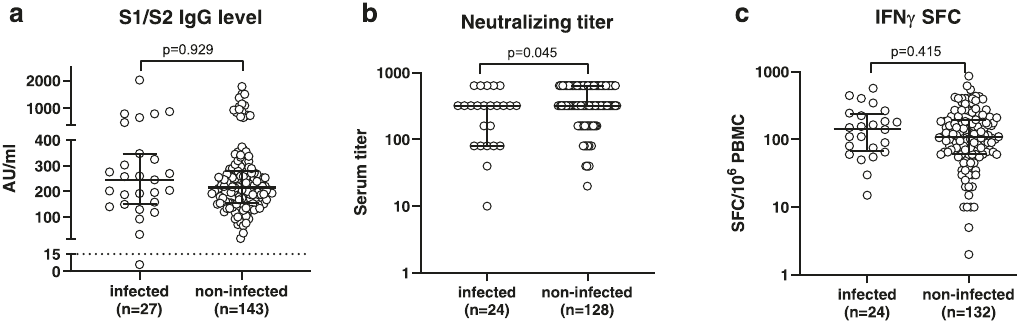
Fig. 3 Antibody and T-cell responses in vaccinated healthcare workers with or without SARS-CoV-2 breakthrough infections. a Anti-spike IgG level (AU: arbitrary units); b serum neutralizing titer; c IFN γ -producing spot forming cells (SFC)/10 6 peripheral blood mononuclear cells (PBMC). Immune response was determined within 48 h after diagnosis in infected subjects, and 21 days after complete vaccination schedule in non-infected subjects. Median values with interquartile ranges are shown. Mann – Whitney U-test (two-sided) was used for statistical